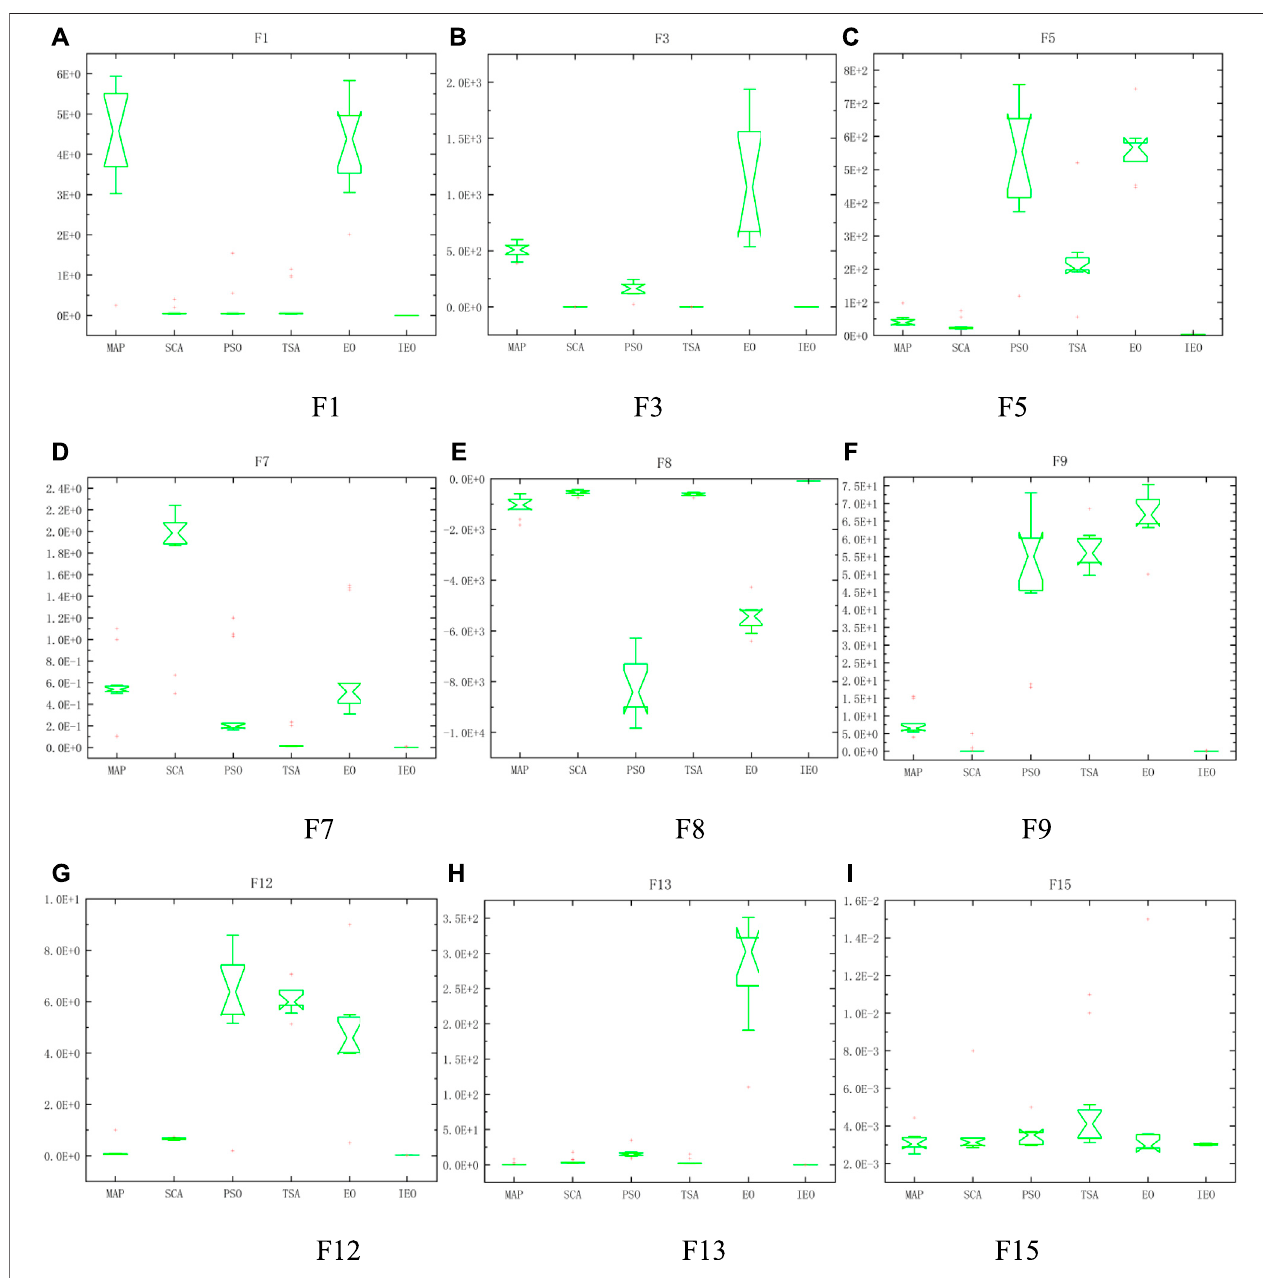
FIGURE 4 | Boxplot comparison of nine test functions. IEO and fi ve classical algorithms run independently for 50 times IGD index box diagram.